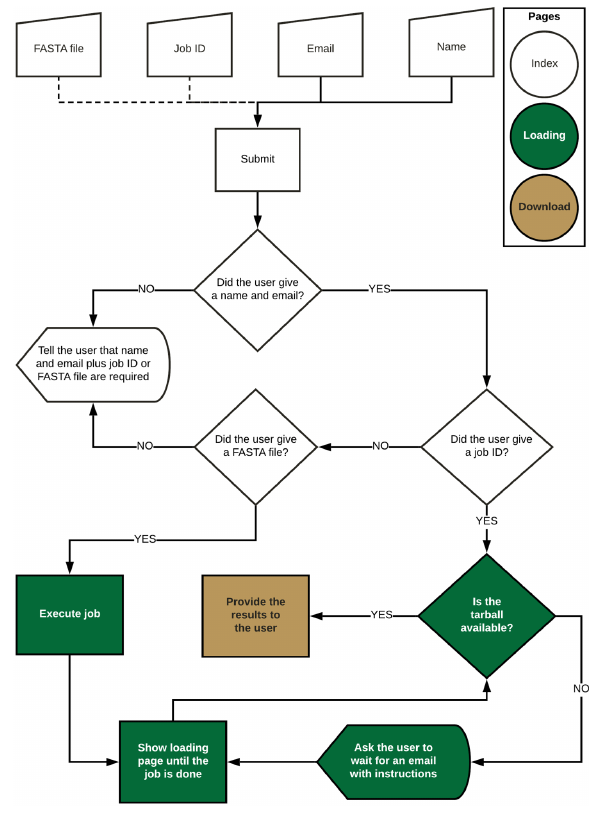
Figure 4. Main steps of the FLAVi-Web interface